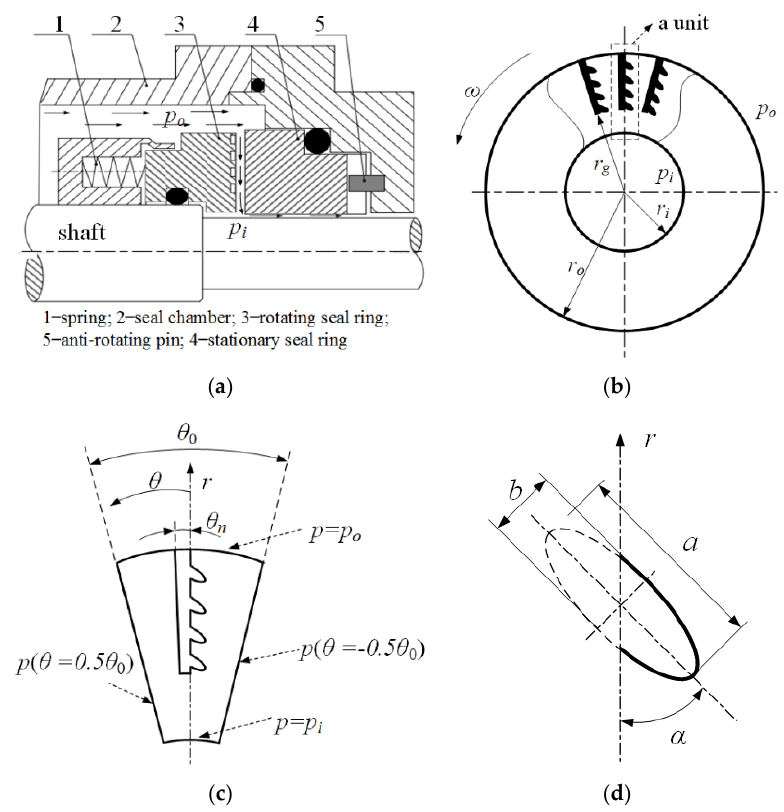
Figure 1. Geometrical model of the seal face with semi salix leaf textures: ( a ) diagram of gas seal, ( b ) textured rotating seal ring, ( c ) one periodic textured unit, ( d ) a micro dimple.